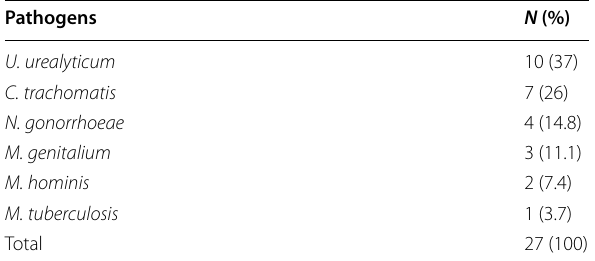
Table 2 Demographic features of the patients Demographic features